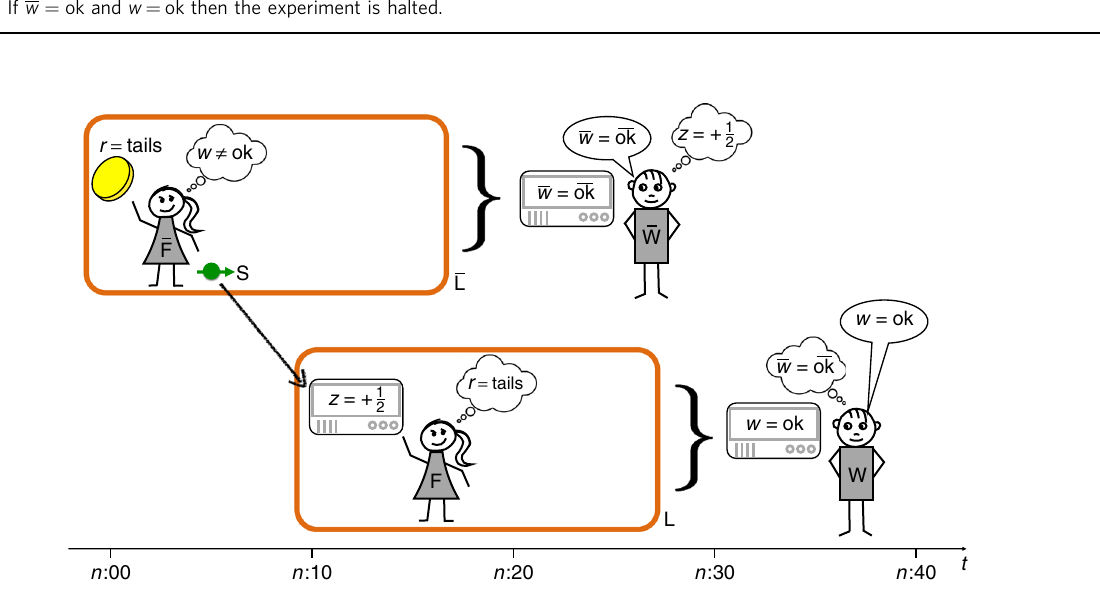
Fig. 2 Illustration of the Gedankenexperiment. In each round n = 0, 1, 2, … of the experiment, agent F tosses a coin and, depending on the outcome r , polarises a spin particle S in a particular direction. Agent F then measures the vertical polarisation z of S. Later, agents W and W measure the entire labs L and L (where the latter includes S) to obtain outcomes w and w , respectively. For the analysis of the experiment, we assume that all agents are aware of the entire procedure as speci fi ed in Box 1, but they are located at different places and therefore make different observations. Agent F, for instance, observes z but has no direct access to r . She may however use quantum theory to draw conclusions about